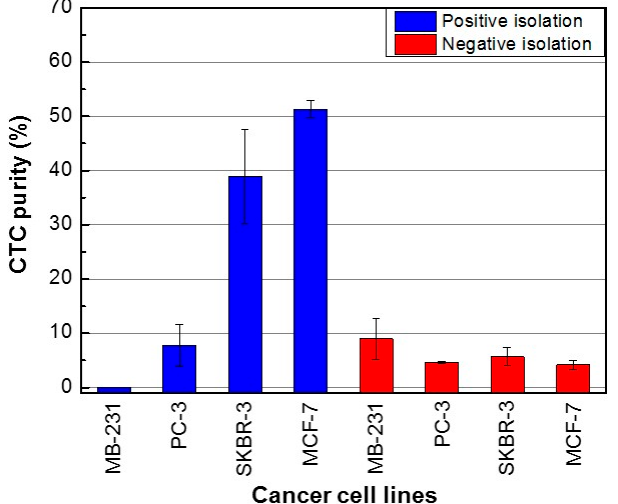
Figure 5. Purity of cancer cells isolated using the PosCTC- µ Chip and the NegCTC- µ Chip from 500- µ L blood samples spiked with the CTCs. Data are means of triplicate determinations.